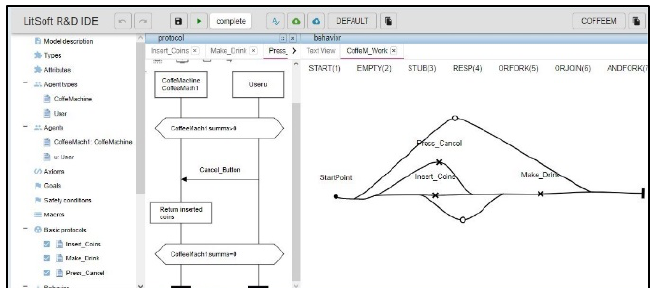
Figure 5. Model creator